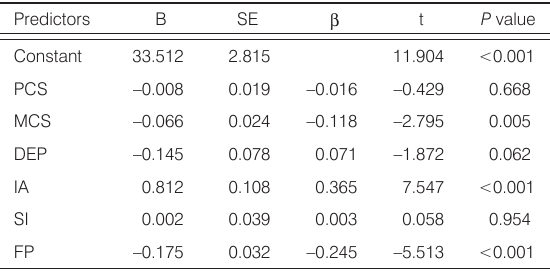
Table 4. Predictors of EM among migrant old parents (N =